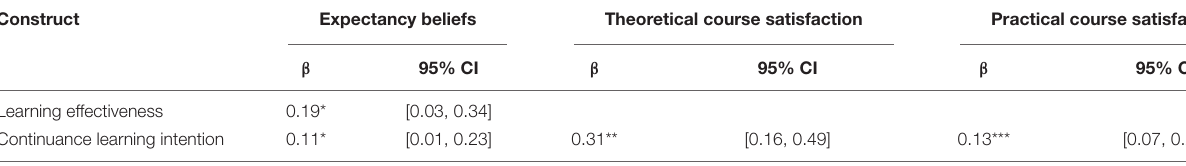
TABLE 5 | Indirect effects analysis.